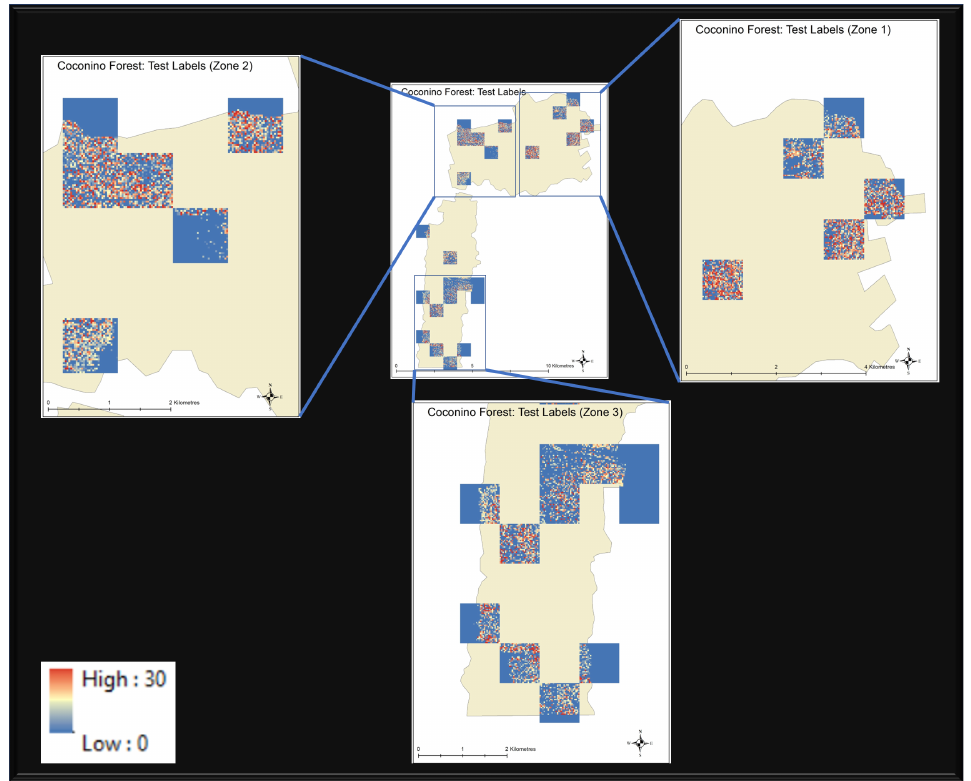
Figure 2. Visual interpretation of test data set distribution over the area of study. The rest of the area (not covered by these tiles) makes the training